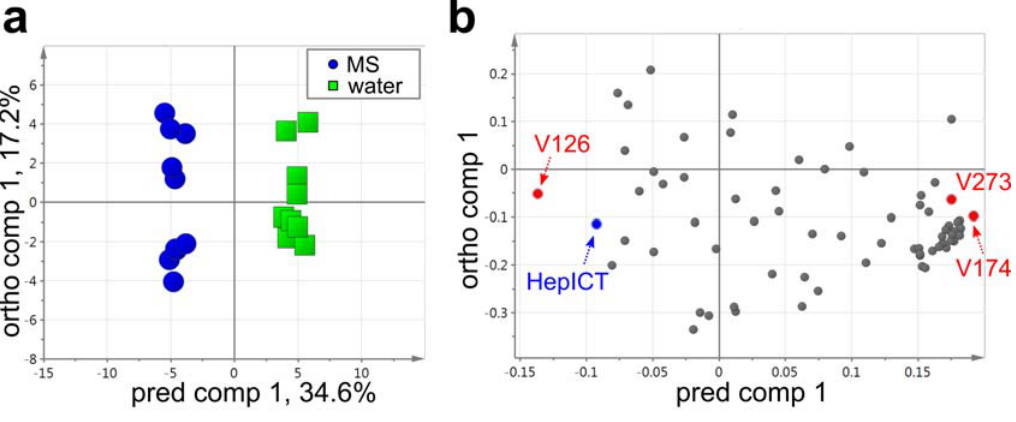
Figure 5. O2PLS-DA score scatter plot ( left ) and loading plot ( right ) of VOC profiles elicited from Arabidopsis seedlings grown under the two different conditions. Each symbol represents an independent sample in the score scatter plot and an independent annotated peak in the loading plot. The levels of VOCs annotated as V126, V174 and V273 emitted from the samples grown in water (biological replicates, n = 10) showed significant changes, when compared with those grown in MS (biological replicates, n = 10) (see Table 2). The metabolites were extracted according to the first-weight vector (w* 1) in addition to the 95% confidence intervals. A p -value (calculated by cross-validated predictive residuals, CV-ANOVA; p cv) of <0.01 for the model was defined as